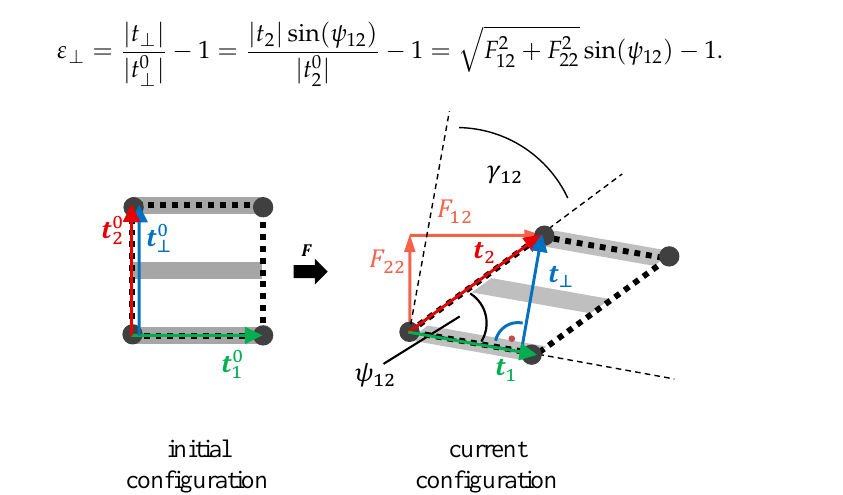
Figure 4. Schematic representation of the calculation of linear strain components (according to